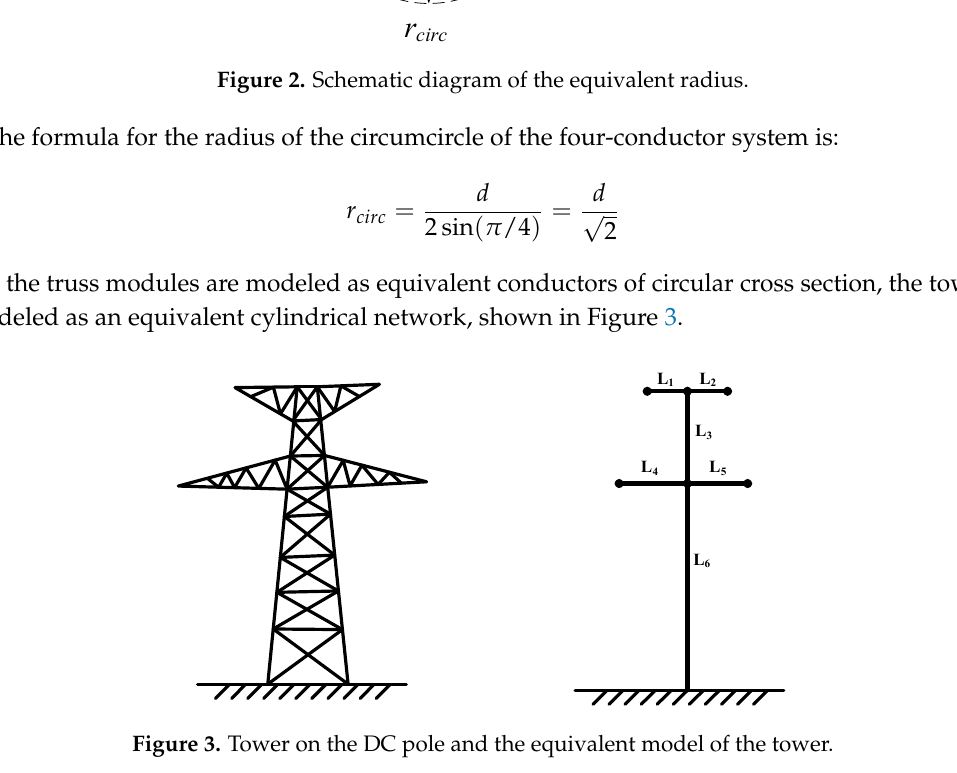
Figure 2. Schematic diagram of the equivalent radius.